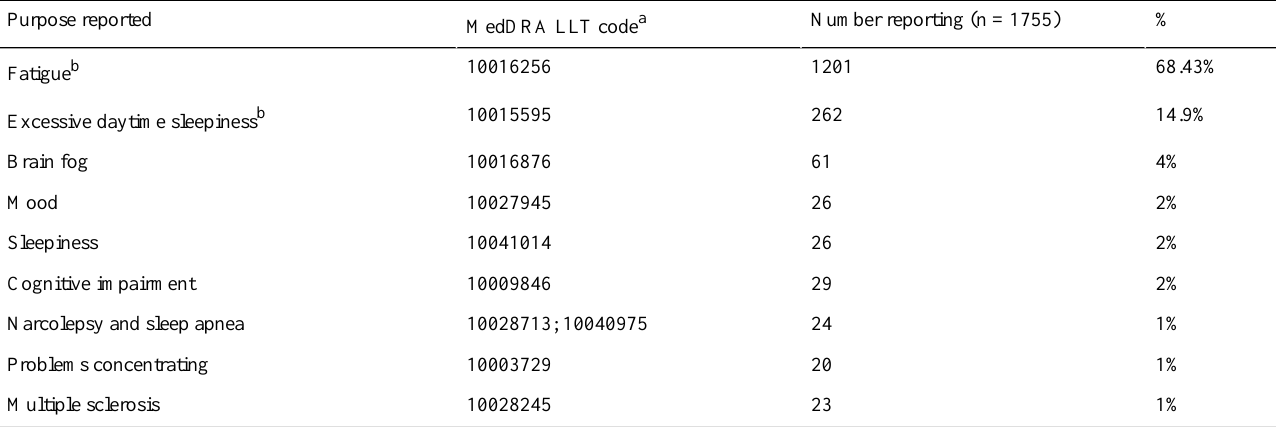
Table 1. Purposes reported by 10 or more users for modafinil